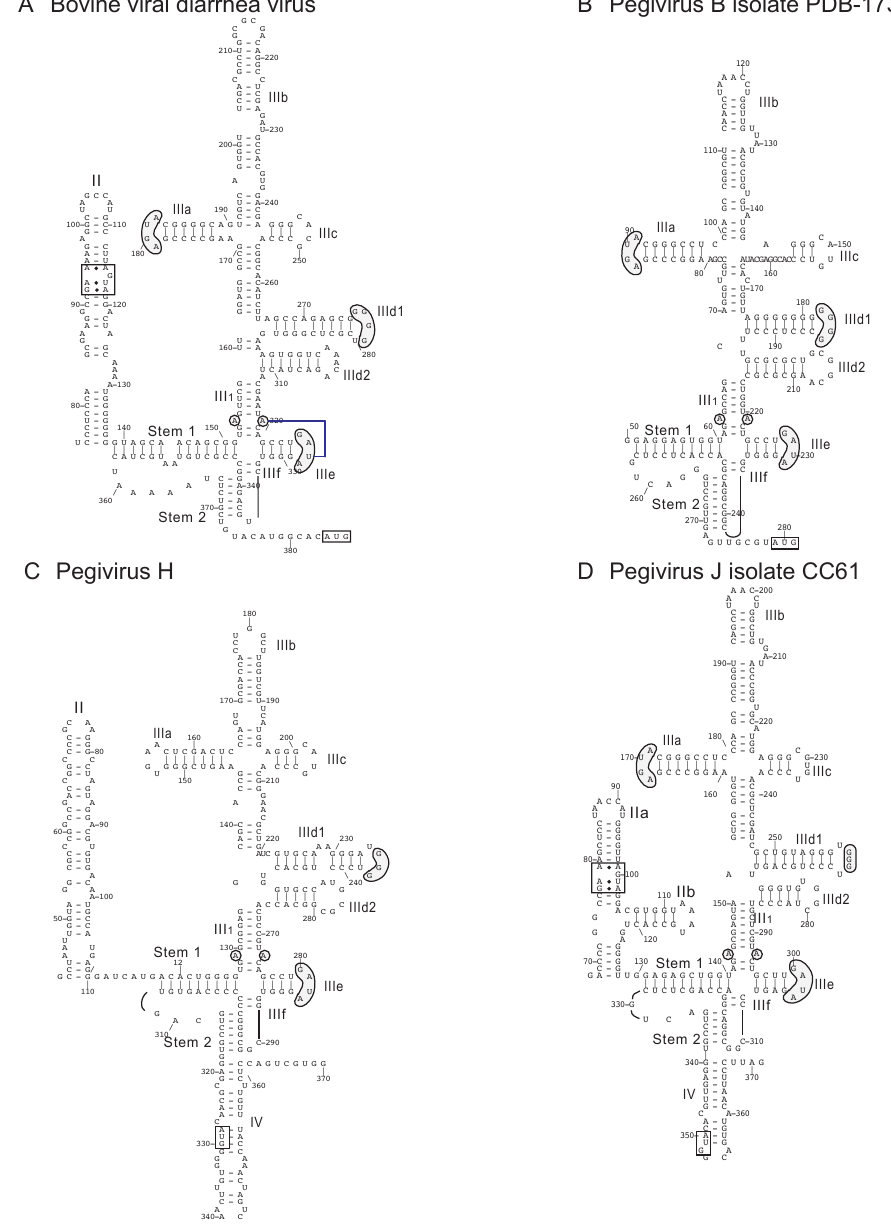
Figure 7. Models of the type IV IRESs of bovine viral diarrhea virus of the genus Pestivirus and related type IV IRESs in members of the genus Pegivirus of Flaviviridae . The models show the structures